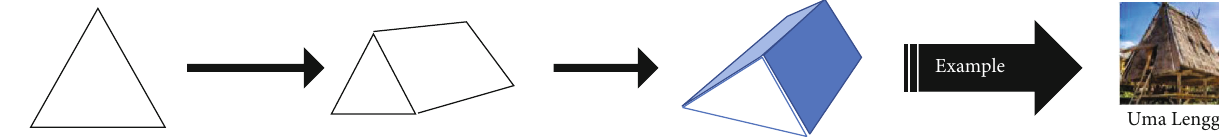
Figure 30: House diagrams of simple house II.